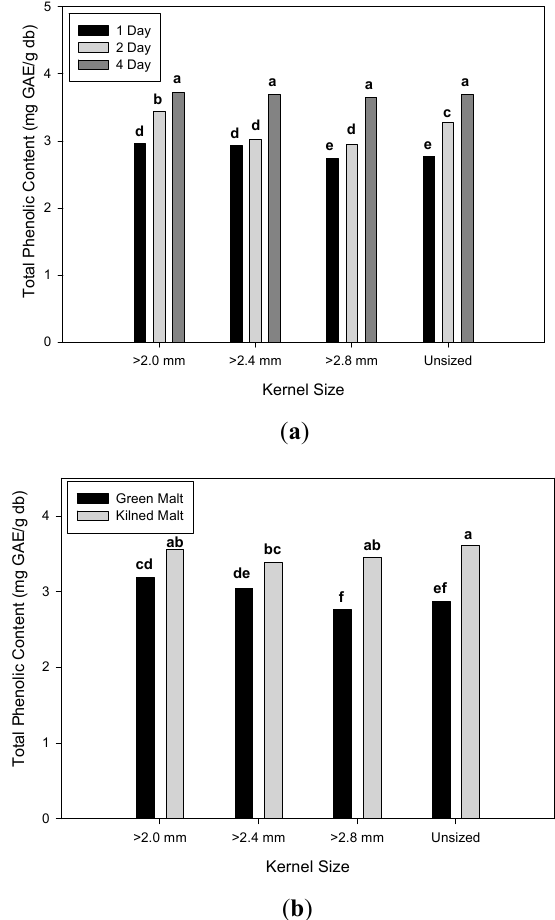
Figure 2. Interaction of malting parameters on the total phenolic content. ( a ) Interaction of germination time and kernel size on the total phenolic content; ( b ) interaction of drying type and kernel size on the total phenolic content. Note: bars with the same letter are not significantly different at p ≤ 0.05.